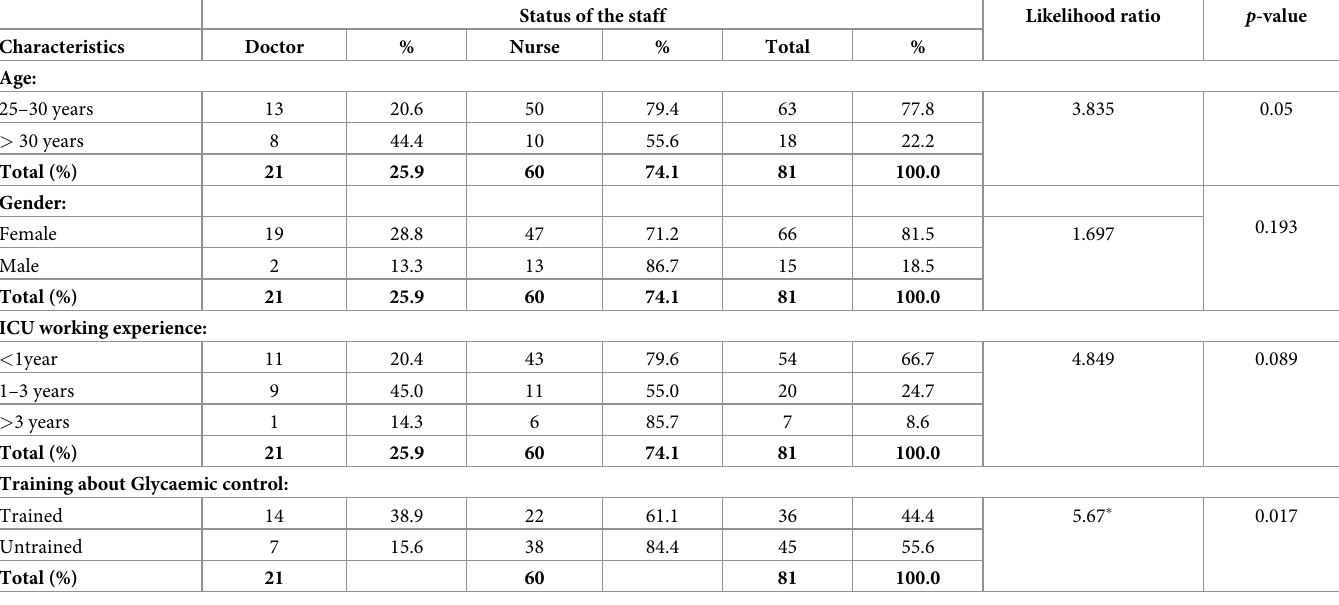
Table 1. Characteristics of the healthcare staff and training on glycaemic control (n = 81).